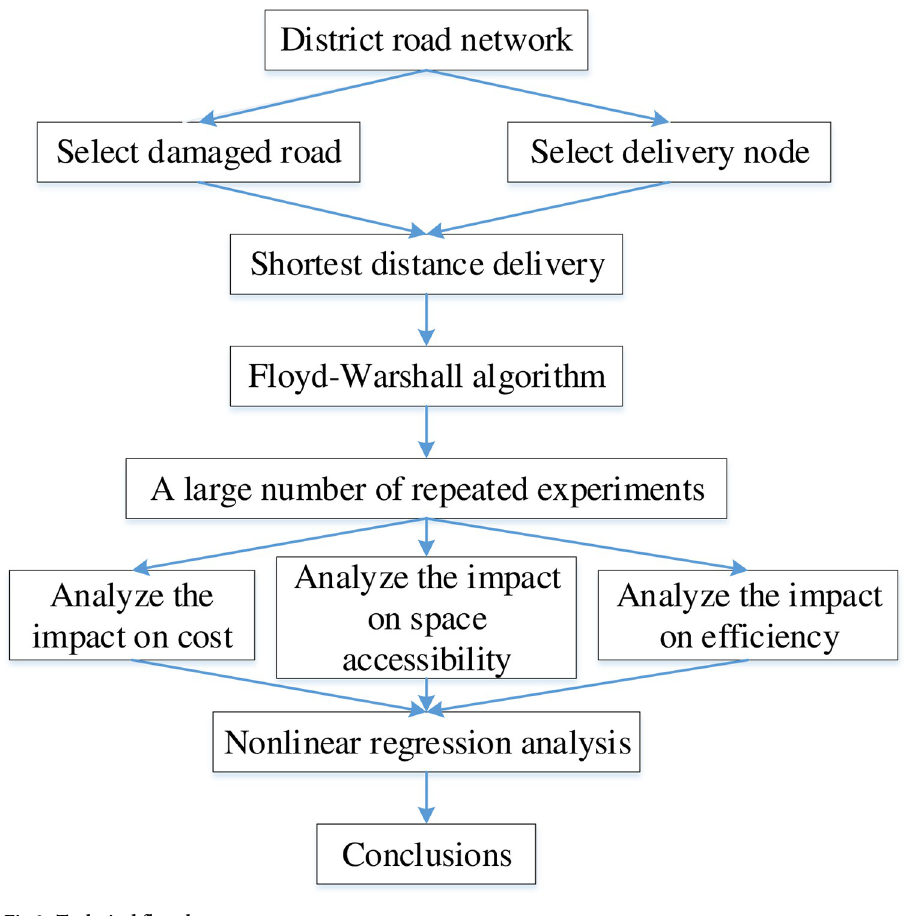
Fig 2. Technical flowchart.